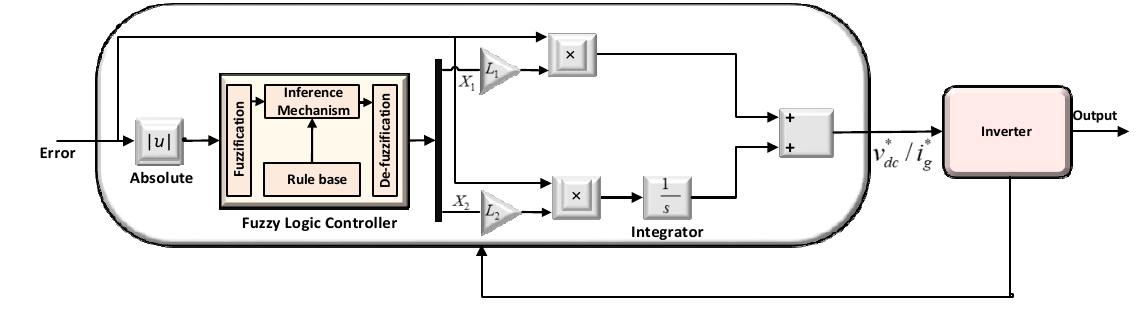
Figure 7. Fuzzy-PI controller.